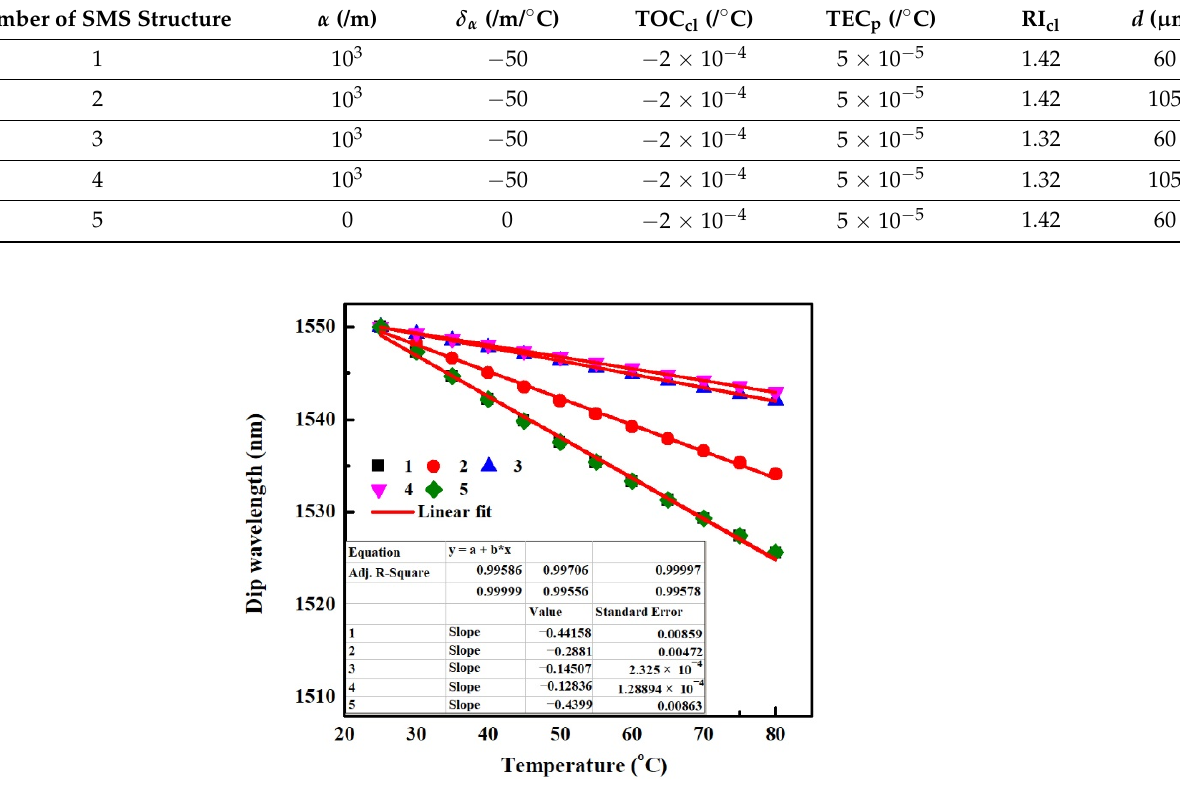
Table 6. Parameters of MMF and packaging shell in the SMS fiber structure.